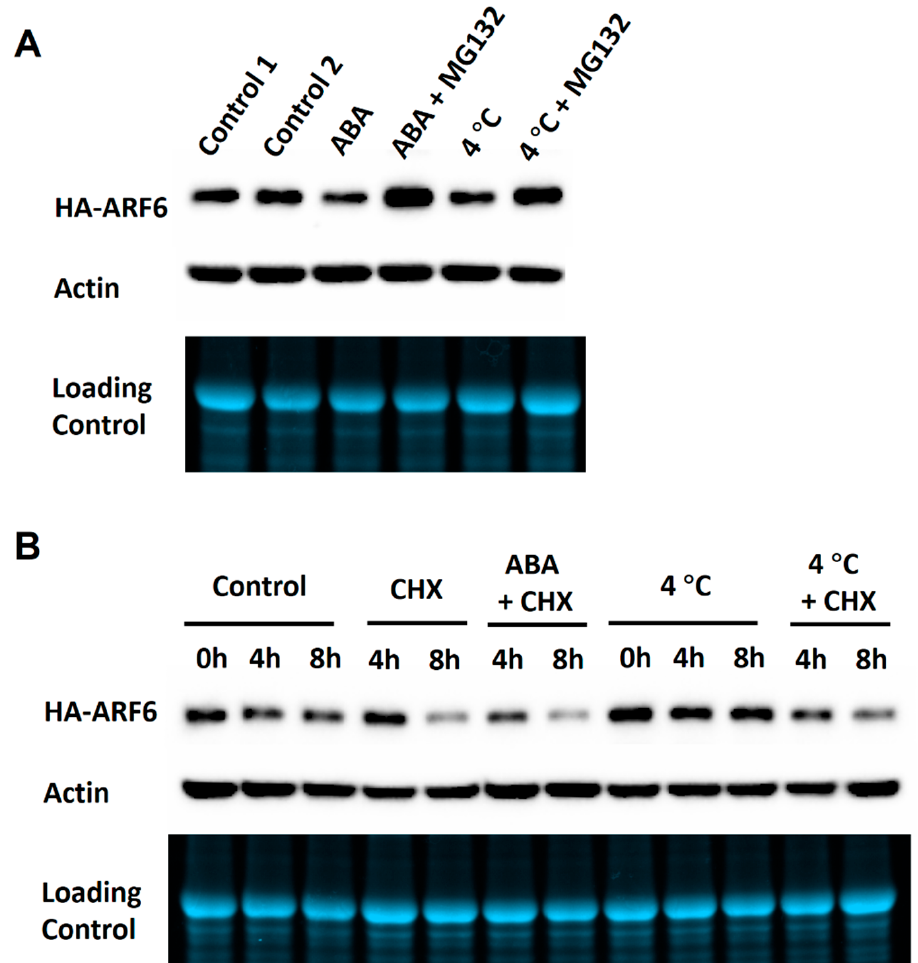
Figure 6. Effects of ABA and 4 °C treatments on HA-ARF6 level in the presence of MG132 or cycloheximide (CHX). Transgenic HA-ARF6 seedlings were grown vertically in Petri plates. Seedlings (10-day old) were transferred to new plates containing a filter paper and 5 mL half-strength MS with or without the treatment reagent. Each plate had about 25 seedlings. After 4 or 8 h of treatment, proteins were extracted and used in electrophoresis (30 µ g protein per lane) in Bio-Rad TGX mini-gels and western blotting. In each subfigure, the first row shows the western blot with an anti-HA antibody. For loading controls, the second row shows the western blot with an anti-actin antibody and third row shows the gel image. The treatment conditions are indicated above the lanes. ( A ) ABA and 4 °C treatments with or without MG132. Control 1: normal half MS medium; Control 2: half MS medium plus 0.1% ethanol and 0.1% DMSO (ABA and MG132 stocks were prepared in ethanol and DMSO, respectively); ABA: 50 μ M; MG132: 25 μ M. ( B ) ABA and 4 °C treatments with or without CHX. Control: half MS medium plus 0.1% ethanol and 0.1% DMSO; ABA: 50 μ M; CHX: 200 μ M.